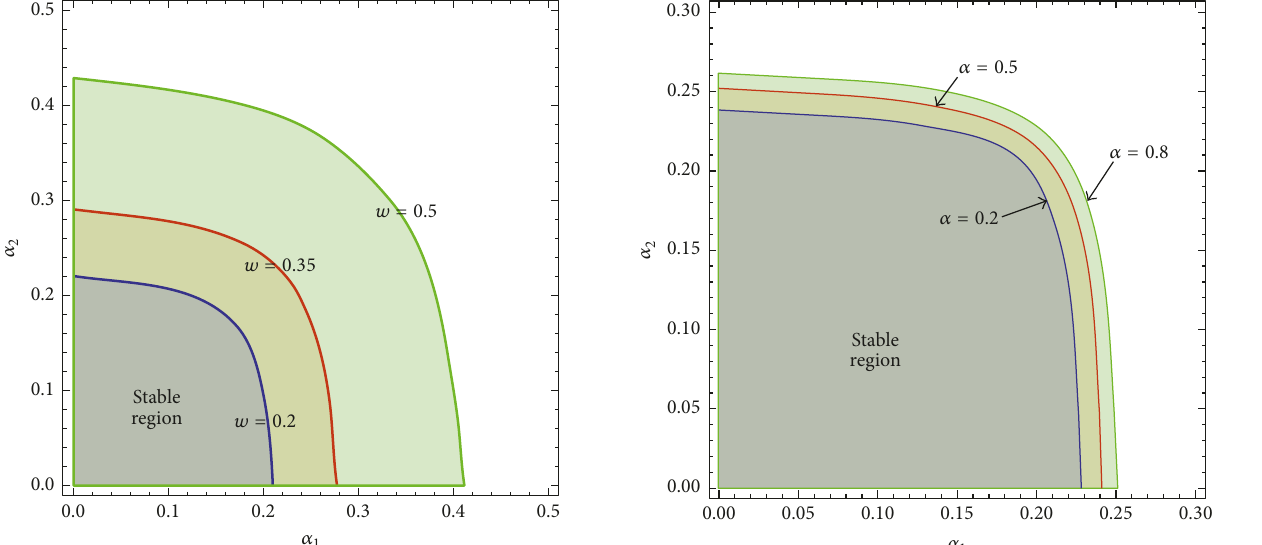
Figure 12: The stable region of adjustment speeds when 𝜃 = 0.6 and 𝑤 = 1 𝑖